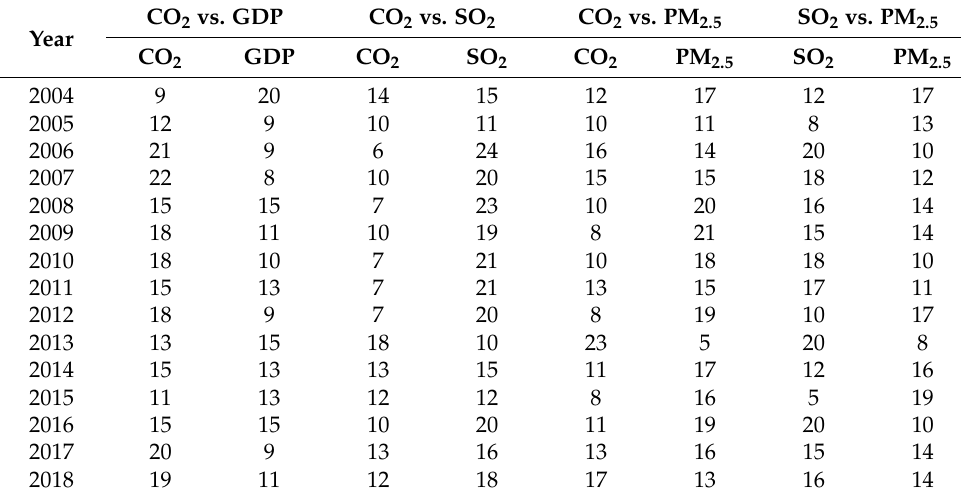
Table 5. Output factor bias